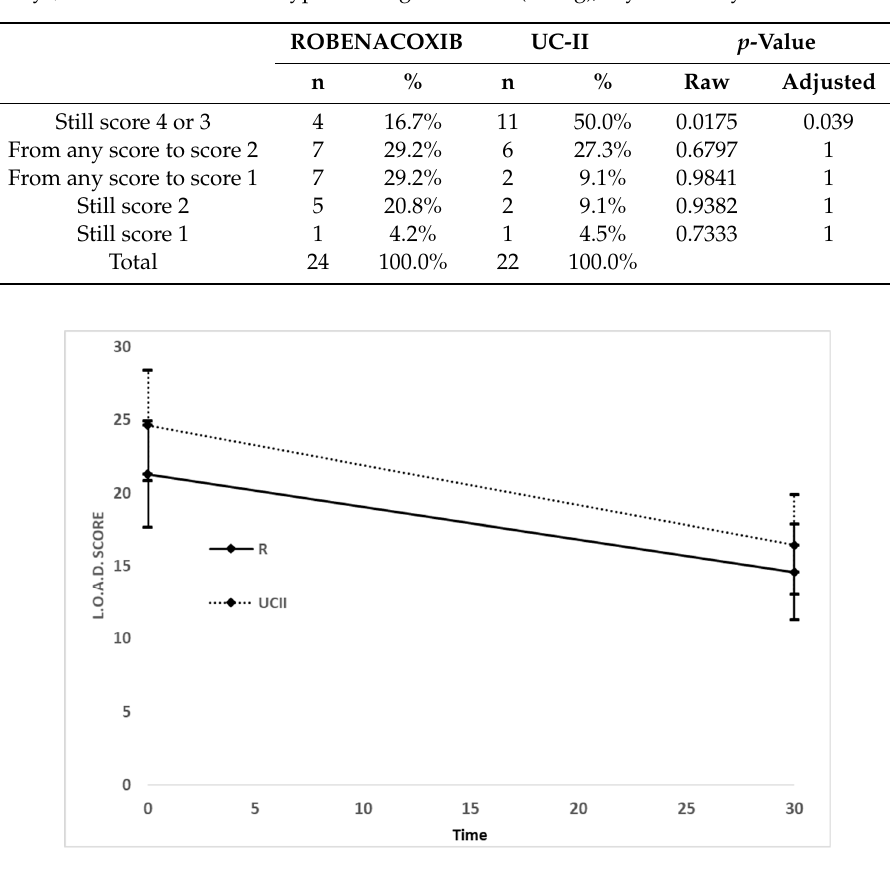
Figure 2. Means and their confidence intervals at 95% of the Liverpool Osteoarthritis in Dogs (LOAD) score by treatment group, at each time of the study.